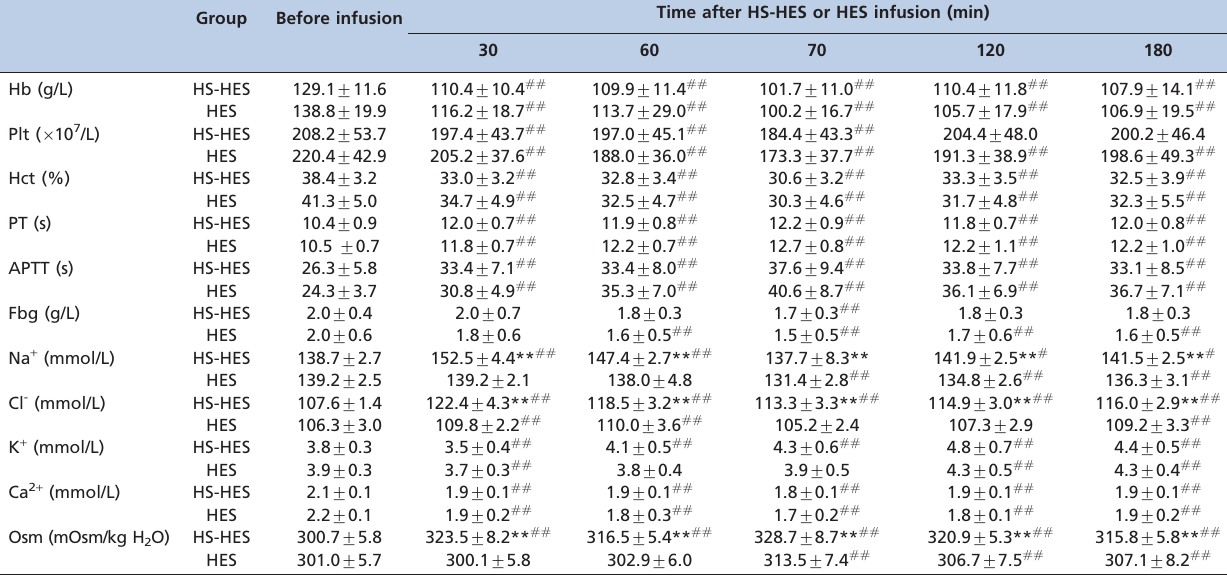
** p , 0.01 versus the HES group, # p , 0.05 versus the measurement before infusion, ## p , 0.01 versus the measurement before infusion. The data are presented as the mean ¡ SD. Hb: hemoglobin concentration, Plt: platelet count, Hct: hematocrit, PT: prothrombin time, APTT: activated partial thromboplastin time, Fbg: fibrinogen concentration, Osm: